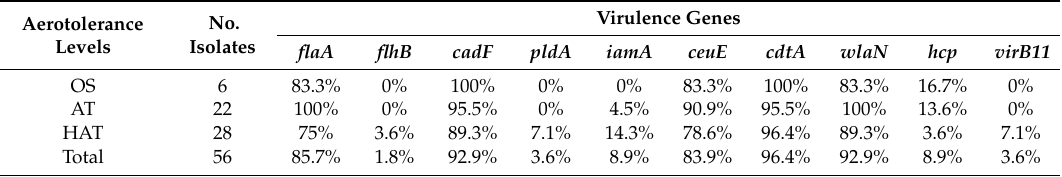
Table 1. Prevalence of virulence genes in Campylobacter coli isolates according to aerotolerance levels. Aerotolerance